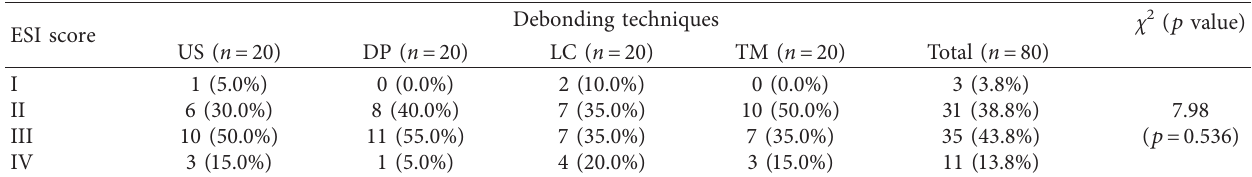
Figure 1: Representative diagram of study outline and Table 1: Enamel Surface Index (ESI) scores with the four techniques used for debonding.